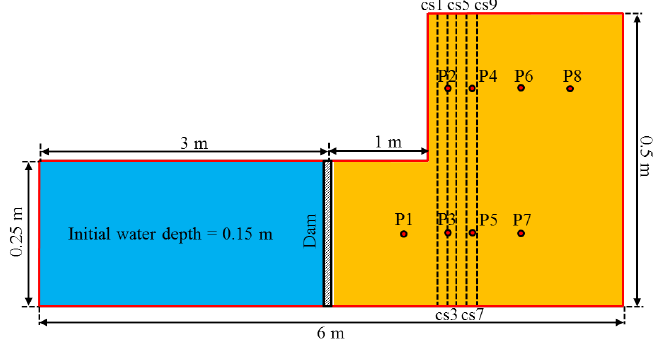
Figure 9. The experimental configuration of dam break flow over movable bed in a sudden-expanded channel (dash lines: measurement cross sections; circles: ultrasonic gauges) [48,49].